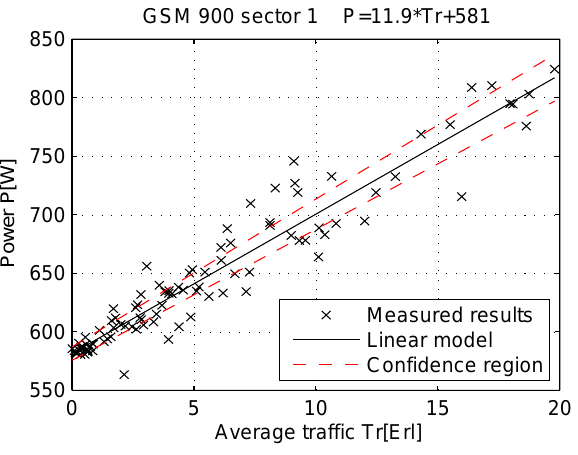
Figure 25. Power consumption model of GSM 900 sector 1 BS rack (total measuring period).